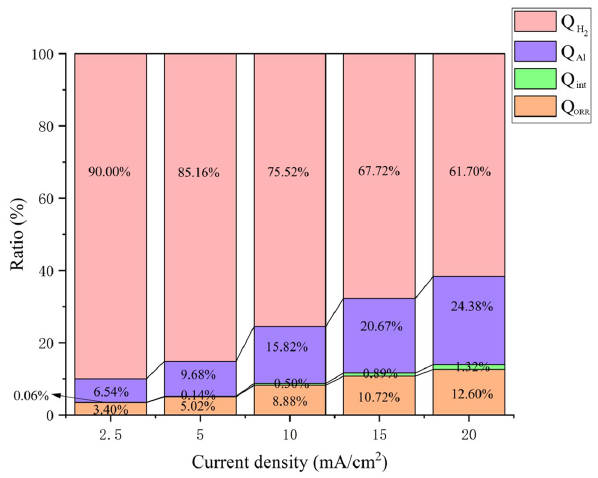
Figure 9. The proportion of Q Al , Q ORR , Q int , and Q H2 in Q tol under different discharge current densi- ties.